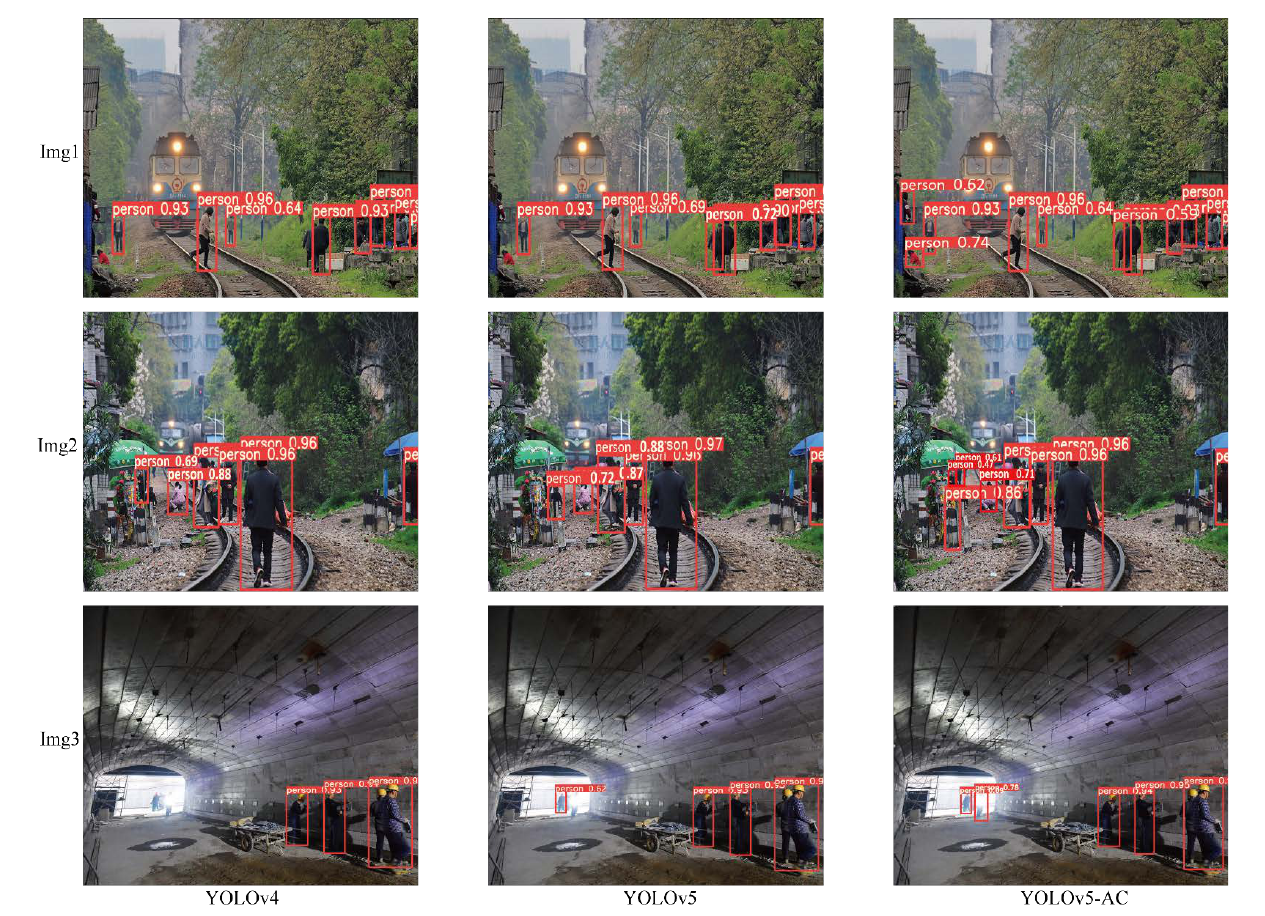
Figure 17. Variation trend of training metrics in the experiment. ( a ) Variation trend of AP. ( b ) Vari- ation trend of Recall. The simulation results of pedestrian detection for each algorithm used in the experi- ment are shown in Figures 18 and 19.